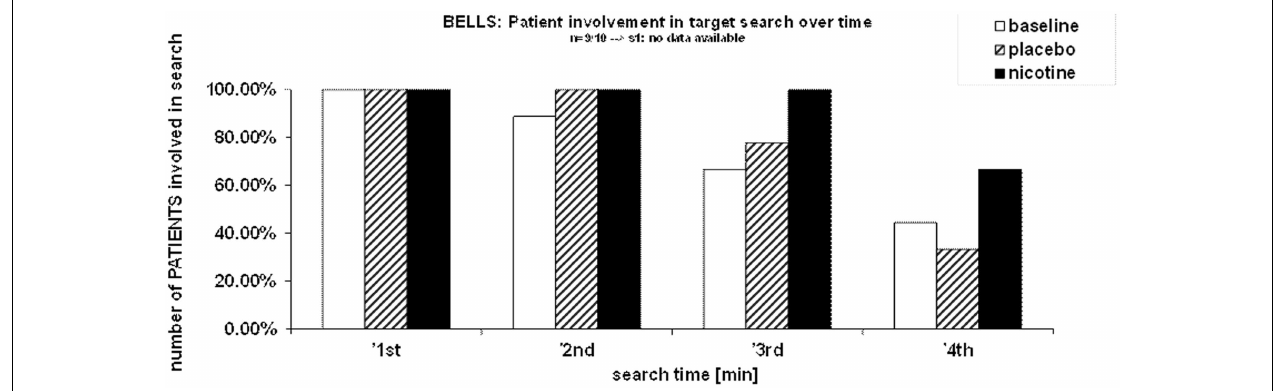
FIGURE 4 | Efficiency (hits/latencies) across different cueing conditions, for targets on both side of space relative to a mid-sagital plane separately